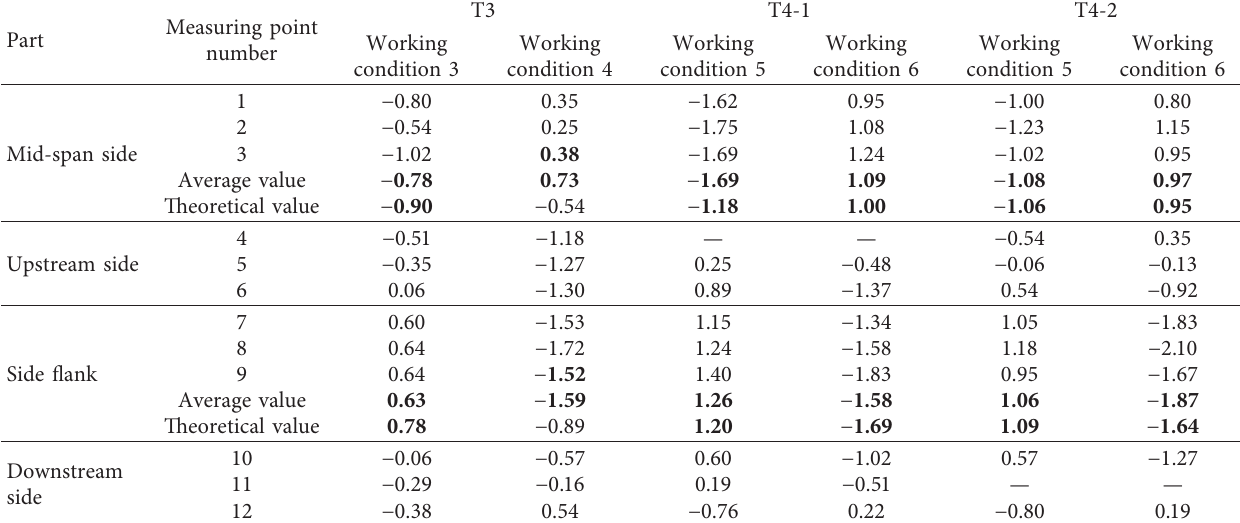
Table 2: Column section test section stress (unit: